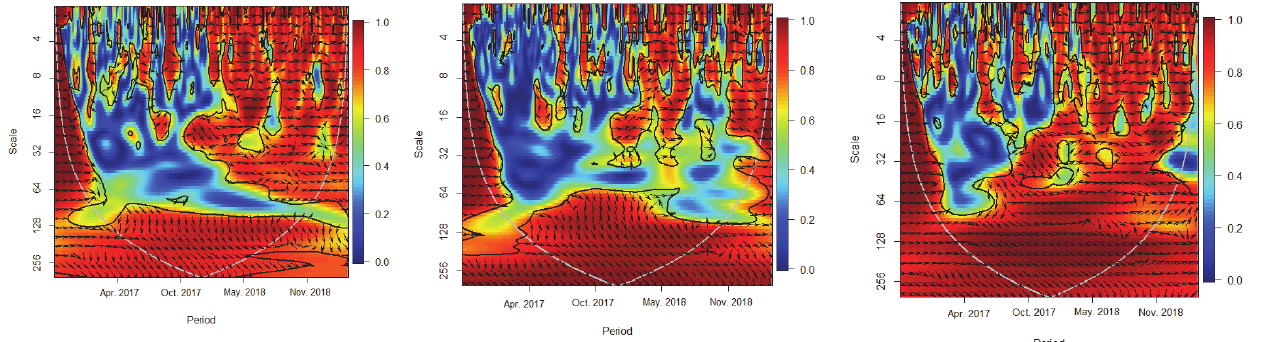
Fig. 9. Wavelet Coherence between Bitcoin and Ethereum